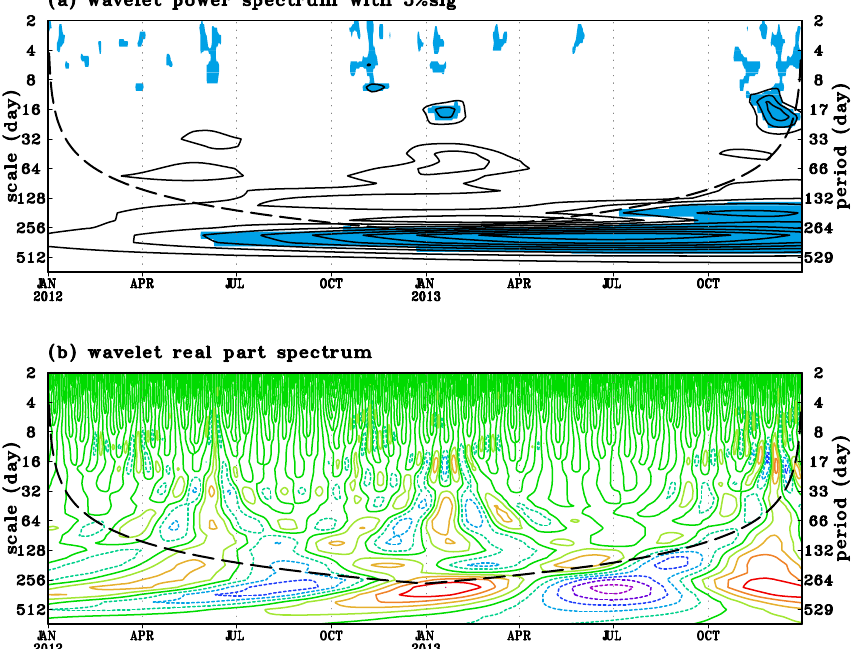
Figure 6. The local wavelet power spectrum (a) and wavelet real part spectrum (b) of the aerosol absorption coefficient at 532nm using the Morlet wavelet. The left axis is the wavelet scale (in day) corresponding to the Fourier period on the right axis. The bottom axis is local time (month). The filled parts in panel (a) indicate passing the 95% confidence level test, and the parts below the dashed line signify